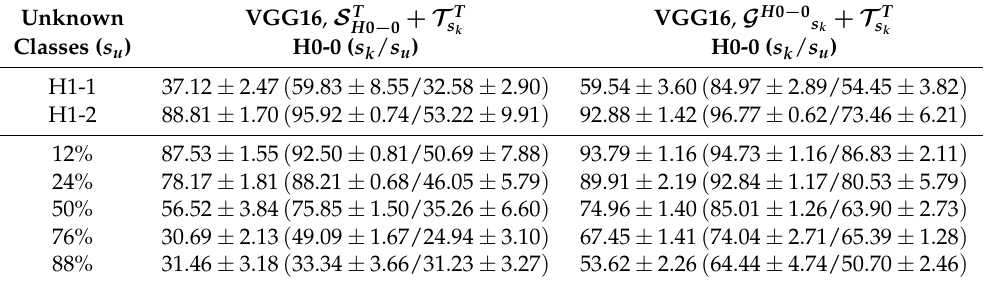
Table 8. Experiments to support Q2 (see main text), all done in T C . Average and standard deviations H 0 − 0 of F1 scores are reported, since each experiment is performed five times. This is done for the all-classes classification problem, but we also show detailed results for known and unknown classes. Table 3 shows the lower and upper bounds for these experiments, i.e., training only on either SYNTHIA-TS or Tsinghua data. In terms of average F1, these bounds are 36.05 and 97.59,